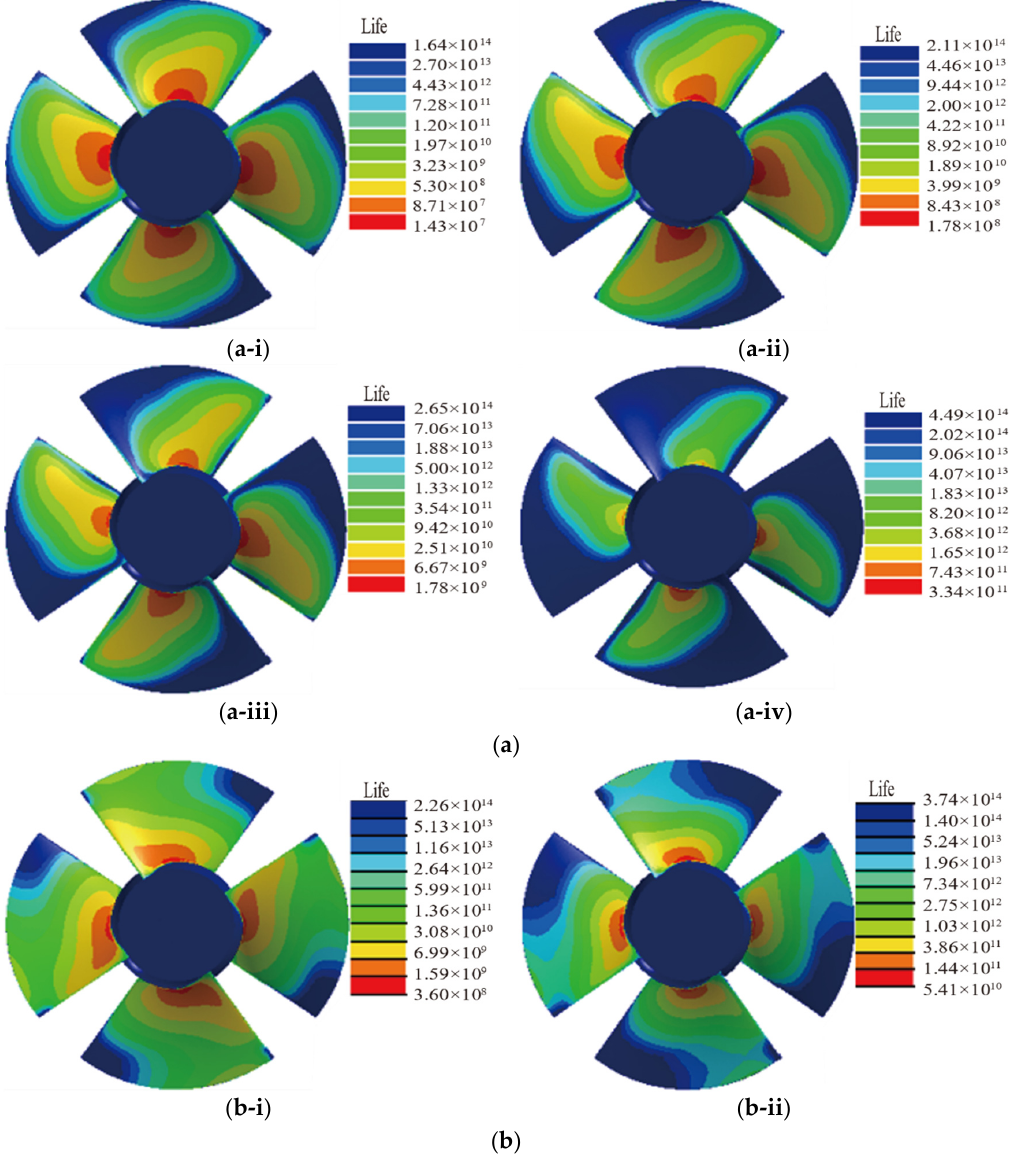
Figure 15. ( a ). Contour diagrams of blade fatigue life under pump conditions. ( a-i ) 0.6 Q, ( a-ii ) 0.8 Q, ( a-iii ) 1.0 Q, ( a-iv ) 1.2 Q, ( b ). Contour diagrams of blade fatigue life under turbine operating conditions. ( b-i ) 0.6 Q, ( b-ii ) 1.0